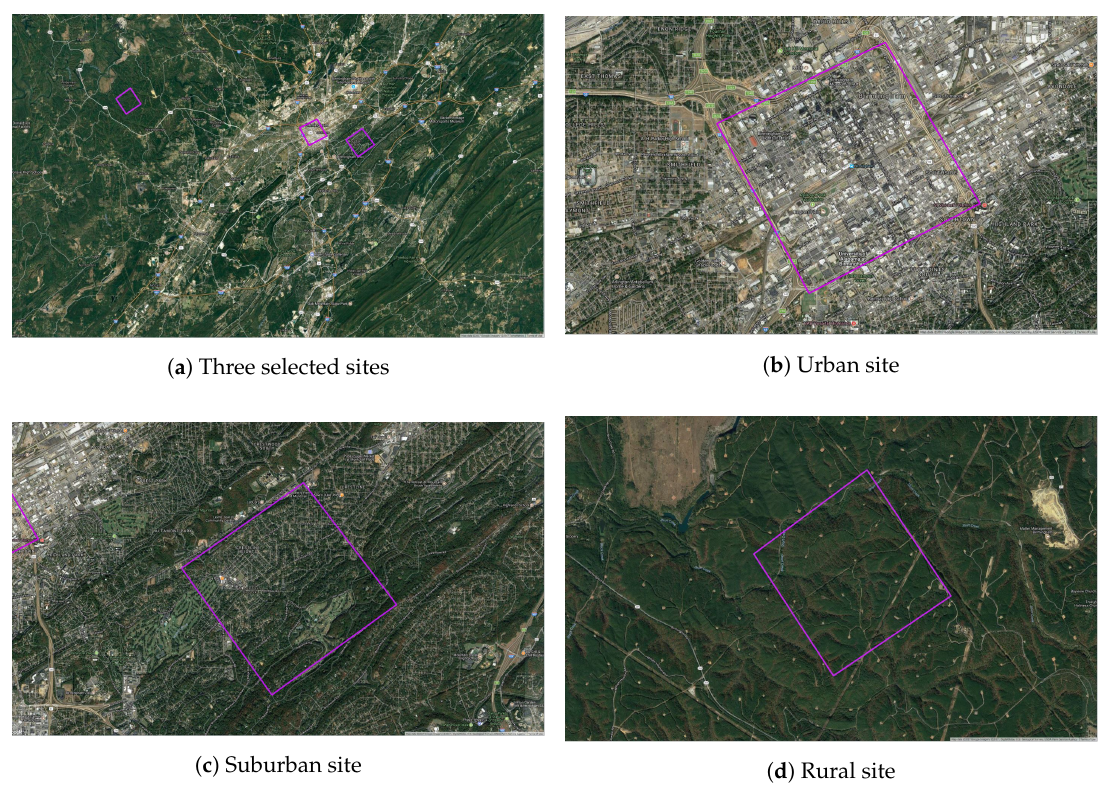
Figure 10. ( a ) Selected three sites, outlined in purple boxes, for UHII study in Birmingham, AL, USA. From west to east, they are rural, urban and suburban areas, respectively; ( b ) The selected study area for the urban site, Downtown Birmingham, AL; ( c ) The selected study area for the suburban region of Mountain Brook, a subdivision of Birmingham, AL, USA; ( d ) The selected area for the rural site of Birmingham, AL, USA. All figures are adopted from Google Earth